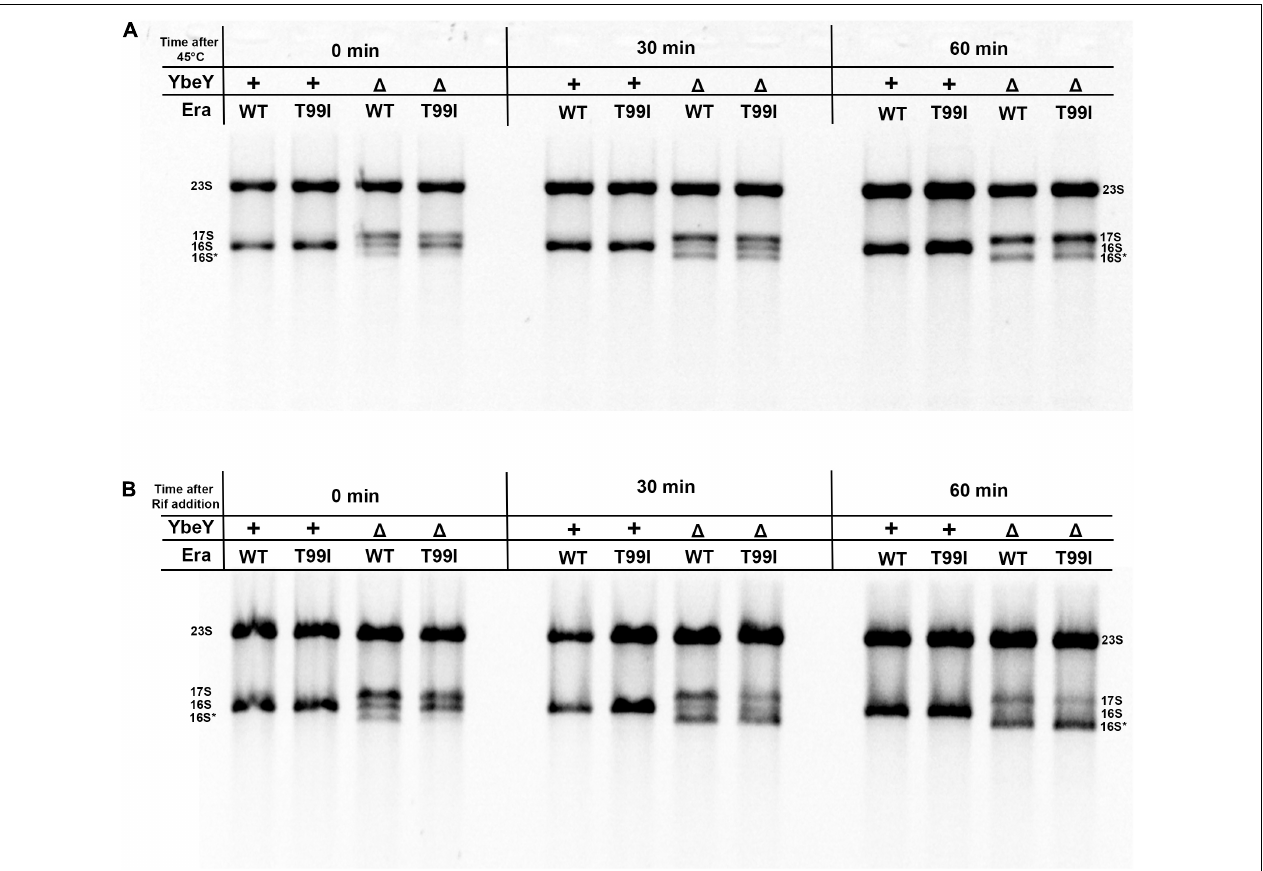
FIGURE 4 | (A) Cell pellets were collected from the indicated strains grown to exponential phase at 37 ◦ C (0 min), after shifting to 45 ◦ C for 30 min and for 60 min. (B) Cell pellets were also collected from the indicated strains after adding 400 µ M rifampicin for 30 min and 60 min at 37 ◦ C. Total RNA extracted from these samples was separated using Synergel-agarose gel electrophoresis. The disappearance of the 16S rRNA band over time is observed. Representative gel images of at least three independent determinations are